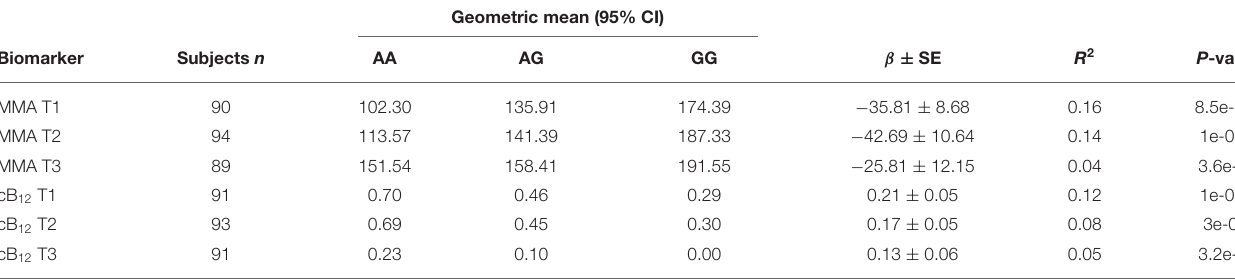
TABLE 3 | Association between the HIBCH rs291466 variant with cB 12 and MMA at T1, T2, and T3 of pregnancy a